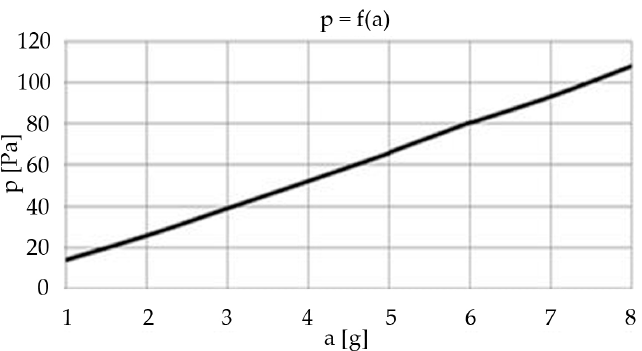
Figure 6. Waveform of the output signal from the transducer as a function of static excitation.